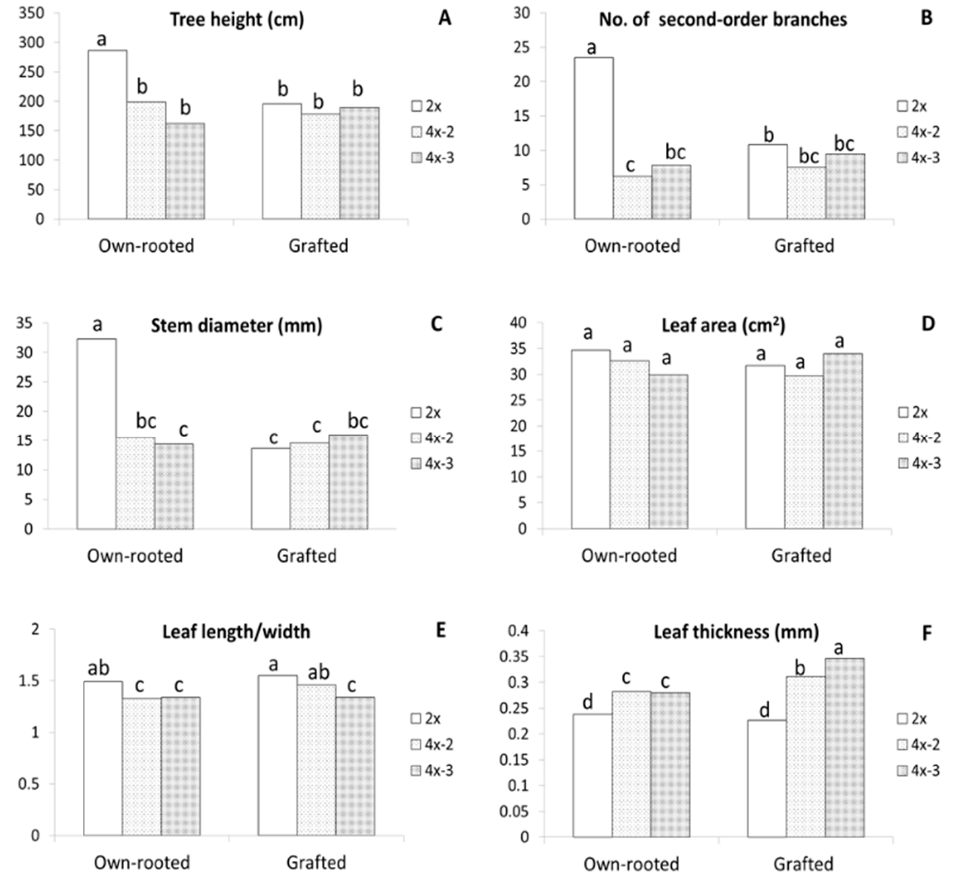
Figure 3. Morphological parameters of the ‘Free Redstar’ apple diploid and its tetraploid clones evaluated for the own-rooted and M9-grafted three-year old trees growing in an experimental orchard of the Research Institute of Horticulture (Skierniewice, Poland) (RIH): ( A ) stem height,( B ) number of second number branches, ( C ) stem diameter, ( D ) leaf area, ( E ) leaf length/wide ratio, ( F ) leaf thickness; means for each trait marked with the same letter do not differ significantly at p = 0.05; Duncan’s test.